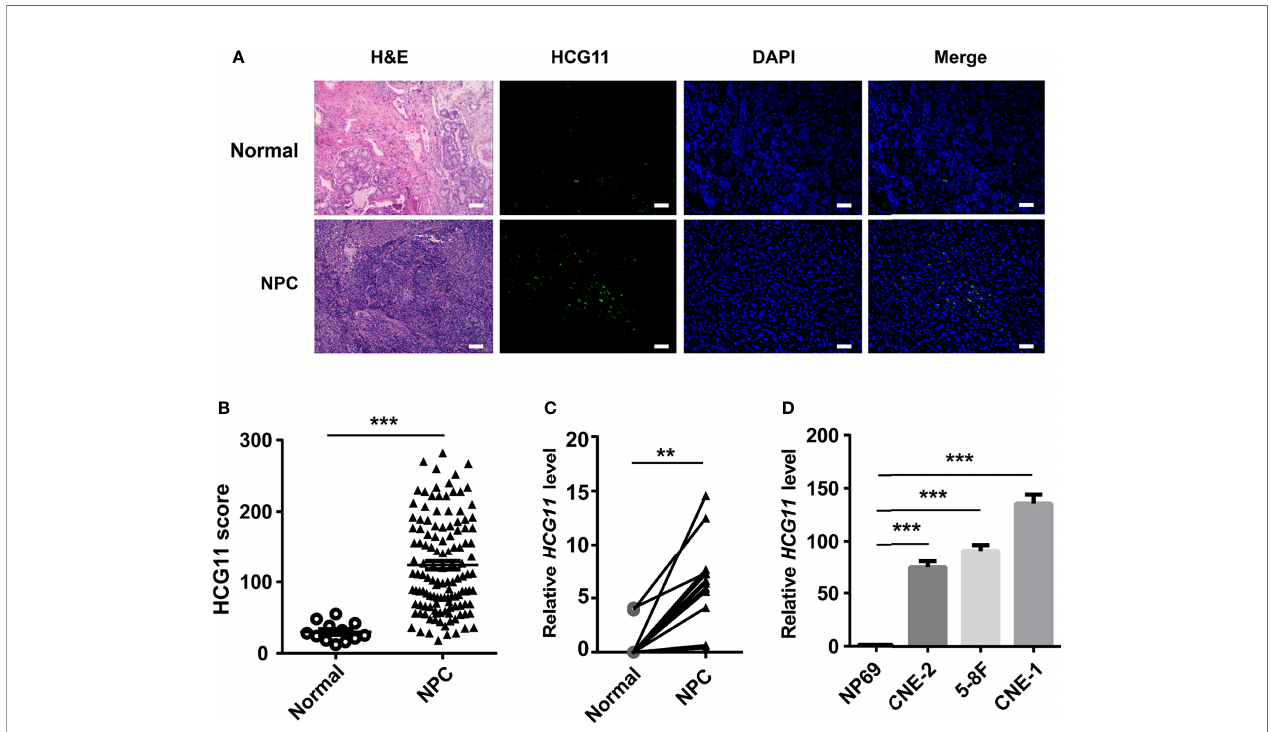
FIGURE 1 | HCG11 is highly expressed in the NPC tissues and NPC cell lines. (A, B) FISH analysis of HCG11 level in the NPC pathological tissues (n = 126) and normal adjacent tissues (n = 12).Scale bar, 20 m m. (C) QPCR analysis of HCG11 in fresh NPC tissue samples and adjacent tissues (n = 12 per group). (D) QPCR analysis of HCG11 expression in epithelial cells NP69 and NPC cell lines (5-8F, CNE-1, CNE-2). Data were presented as Mean ± SEM. **p < 0.01, ***p < 0.001. These experiments were repeated twice (D) .